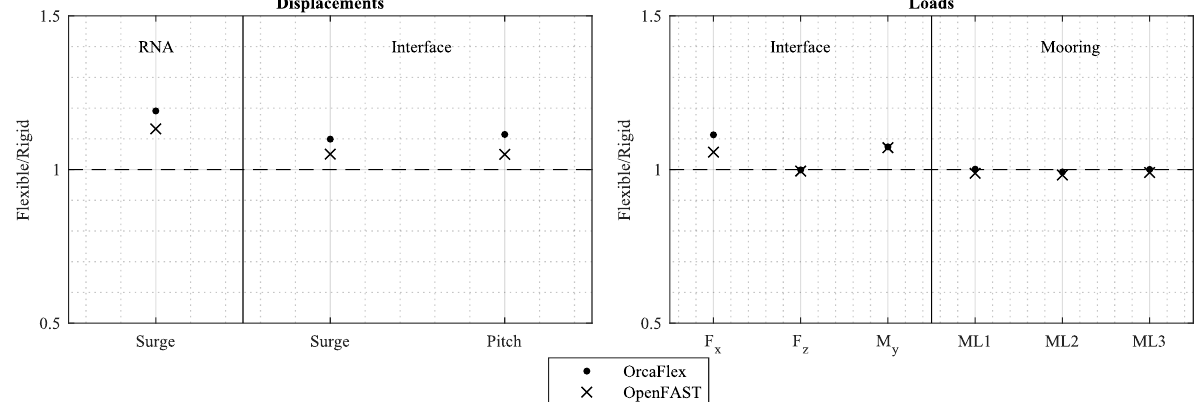
Figure 3. Comparison for the static loading condition. The rigid model is modeled in OrcaFlex. ( Left ) Comparison of displacements. ( Right ) Comparison of loads at interface and in mooring lines. ML1-3 indicate mooring line tension in line 1-3, while F and M denote force and moment, respectively.